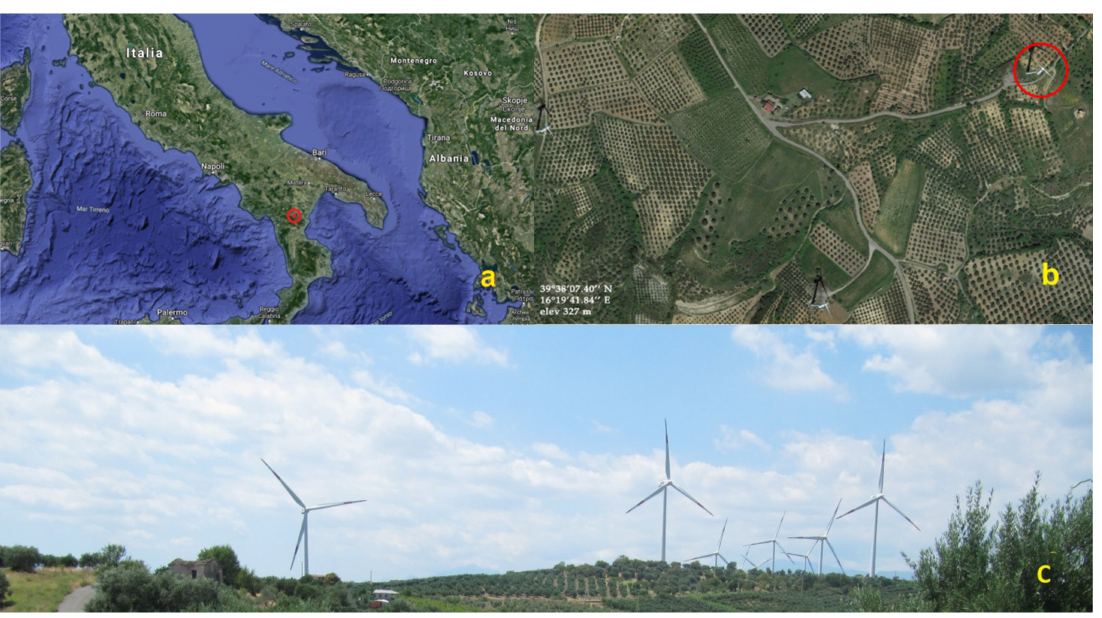
Figure 7. Google © images of the study area: ( a ) geographic position; ( b ) wind farm area (the investigated tower is circled in red); ( c ) panoramic